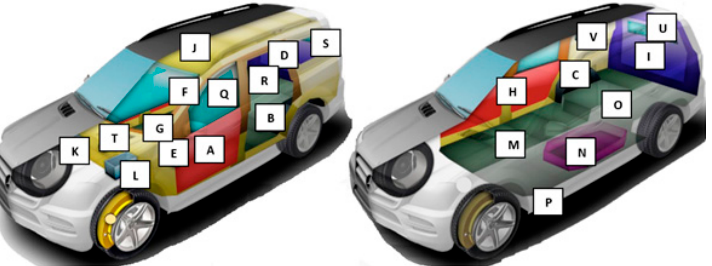
Figure 2. Modifying parts (armoring process) on the SUV model: (A) Front door; (B) Back door; (C) Rear fender; (D) Rear window frame; (E) Door frame; (F) Upper front post; (G) Lower front post; (H) Door divider post; (I) Trunk; (J) Awning; (K) Firewall; (L) Lateral firewall; (M) Front floor; (N) Central floor; (O) Back floor; (P) Floor lower part of the door; (Q) Front window; (R) Back window; (S) Rear wing; (T) Windshield; (U) Trunk window; (V) Rear window.